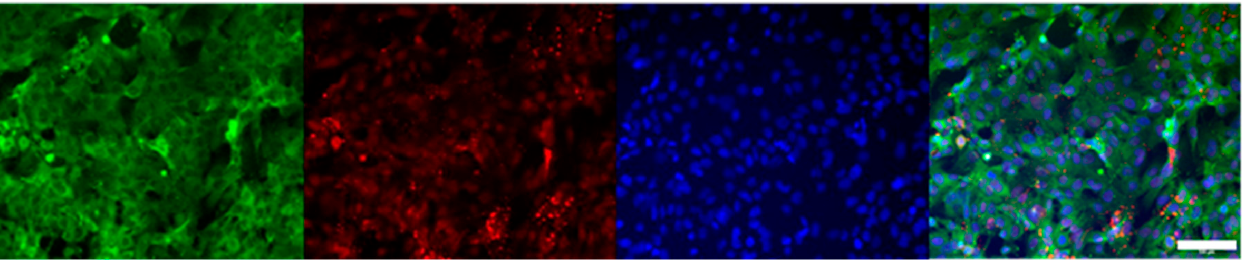
Figure 5. Immunostaining of endothelial cells cultured on a Petri dish. ZO-1 tight junctions are stained in green. VE-cadherin adherens junctions are stained in red. Nuclei are stained in blue. Scale bar 100 µm.